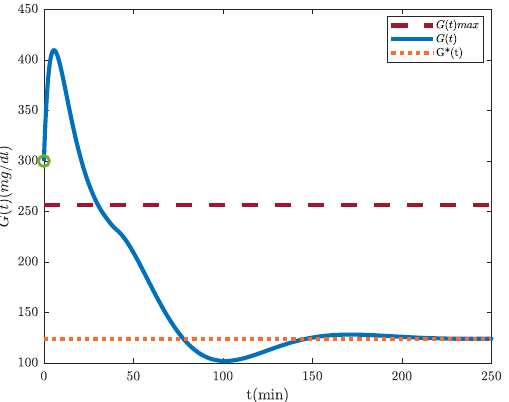
Figure 4. Numerical simulation for type-2 diabetes mellitus system (1)–(5): Solution for G ( t ) (plasma glucose level), taking initial conditions I ( t ) = 1800, D ( t ) = 3000, G ( t ) = 300, and U ( t ) = 100, and parameter values of Table 1. G ∗ ( t ) is the equilibrium point, and G max is the upper bound.